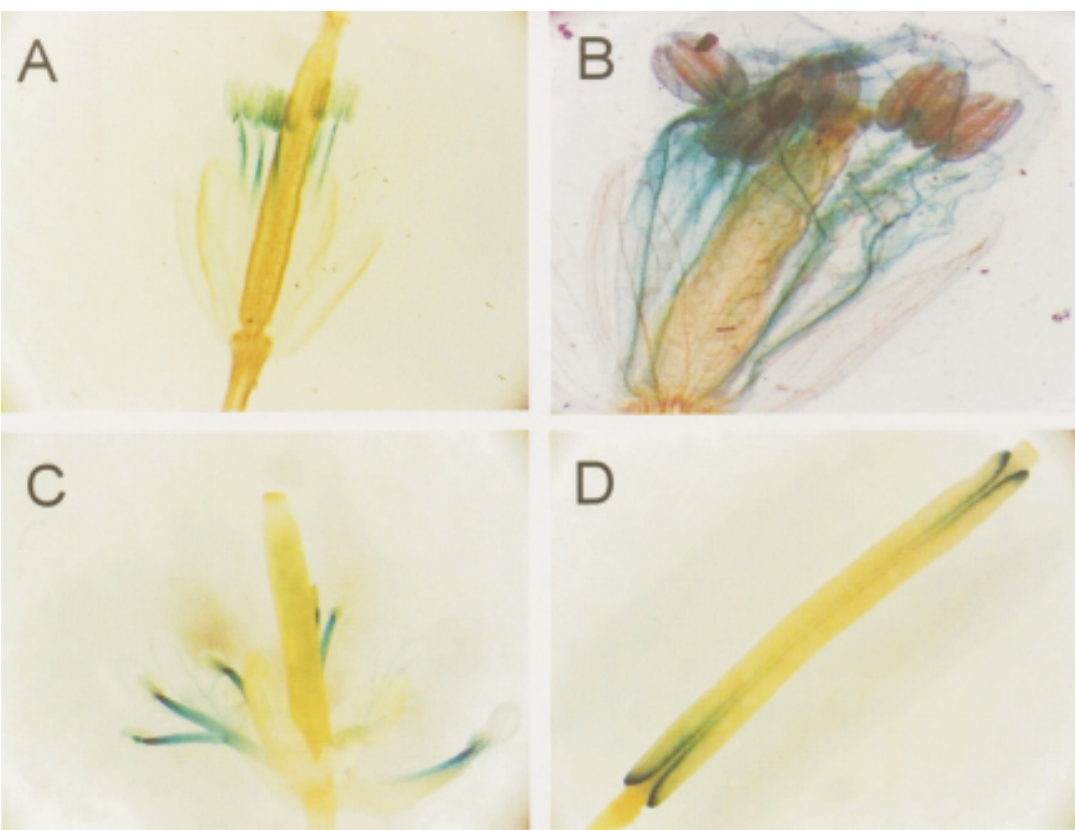
Figure 3 - GUS expression pattern in Arabidopsis plants containing the SHP2 enhancer inserted in the pFBP1::GUS construct (pGD418). (A-B) pFBP1::GUS (pARC069) flower, showing the FPB1 -driven expression in whorls 2 and 3 (petals and stamens, respectively), (A) in stamens and (B) in petals. (C) Flower of a line containing pGD418 construct, showing GUS expression in petals (vasculature) and anther filaments, and weak expression in the ovules. (D) Silique of a pGD418 line. Besides the FBP1 -driven expression in petals and filaments, ectopic GUS expression is observed in the dehiscence